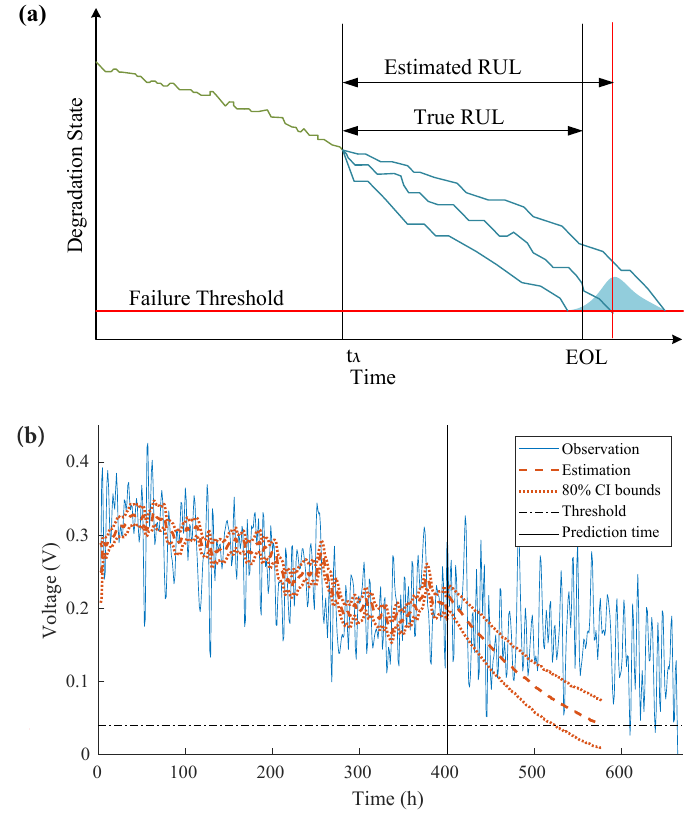
Figure 4. Degradation estimation and RUL prediction: ( a ) illustration of RUL prediction; ( b ) direct observation-based RUL prediction for µ DMFC at t λ = 400